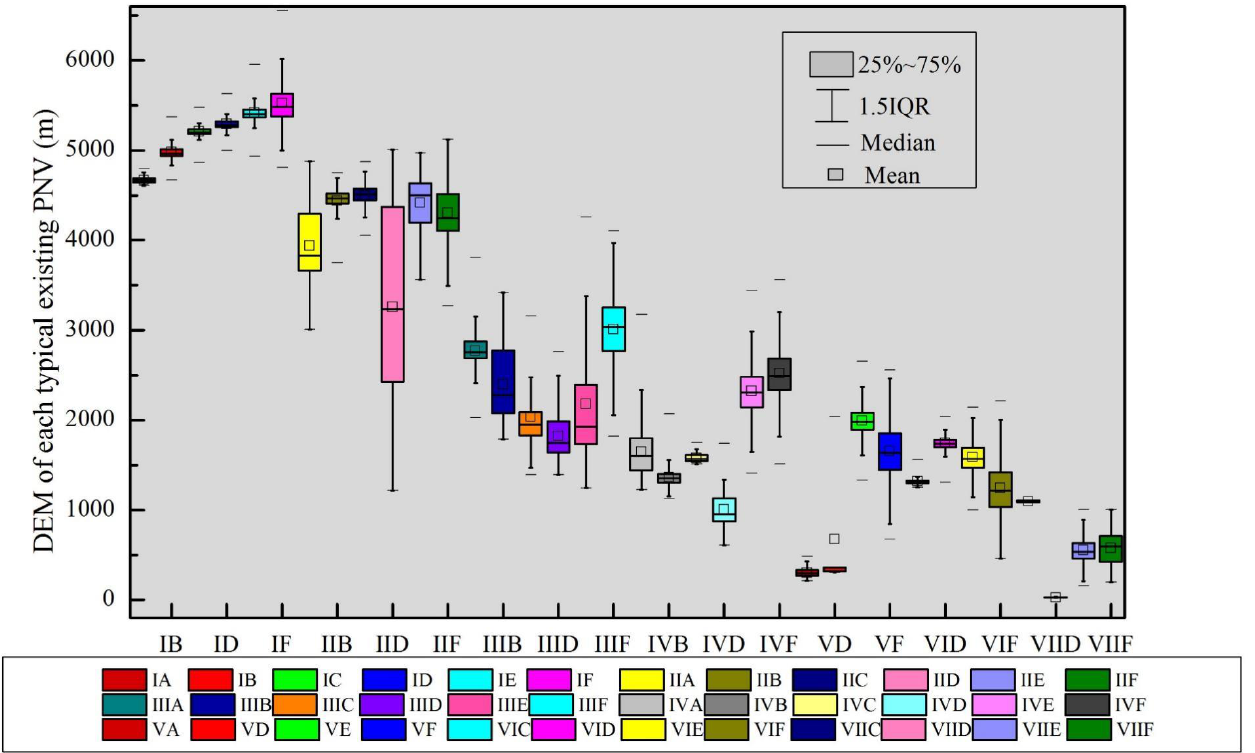
Figure 13. Statistical variability in DEM values for different PNV types in typical areas. Refer to Table A2 for PNV classification code. IQR represents the interquartile range.